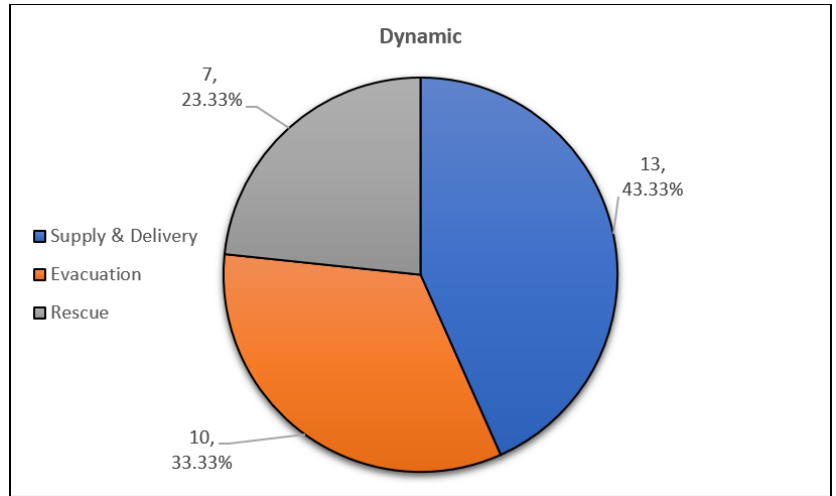
Figure 24. Selected Humanitarian Operation based on SVRP.